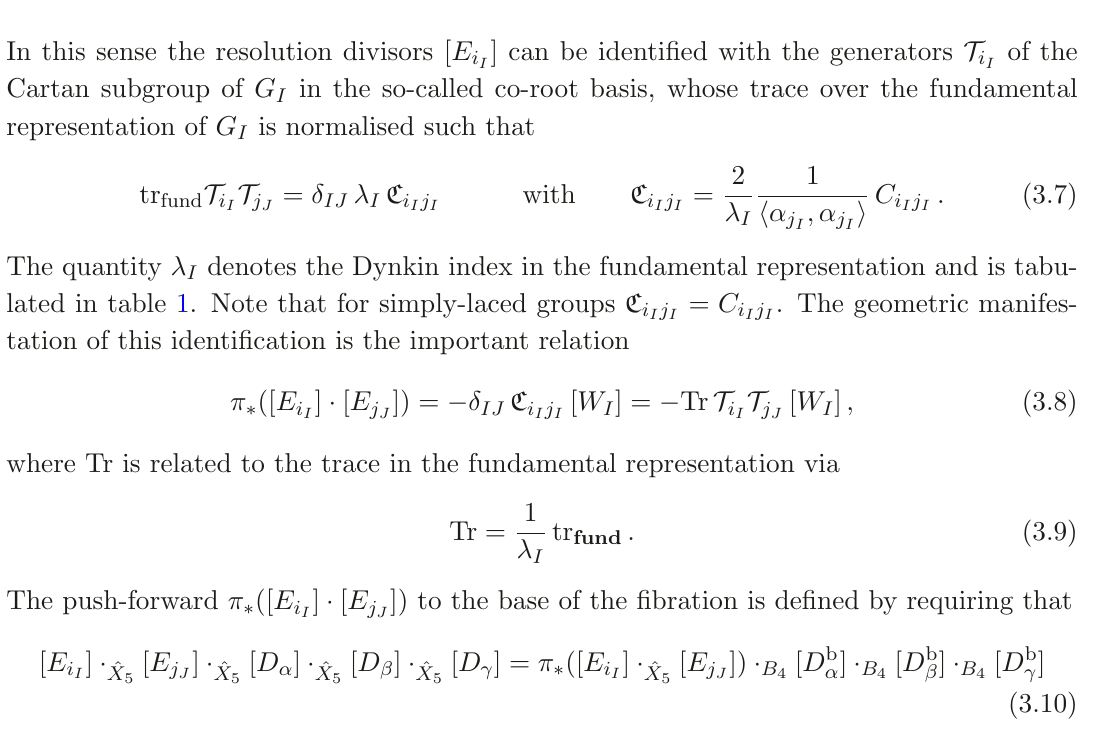
Table 1 . Dynkin index of the fundamental representation for the simple Lie